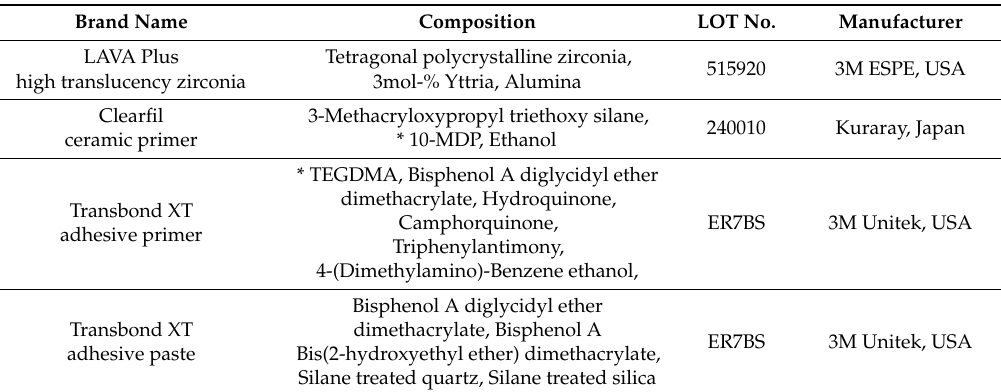
Table 1. Materials used in this